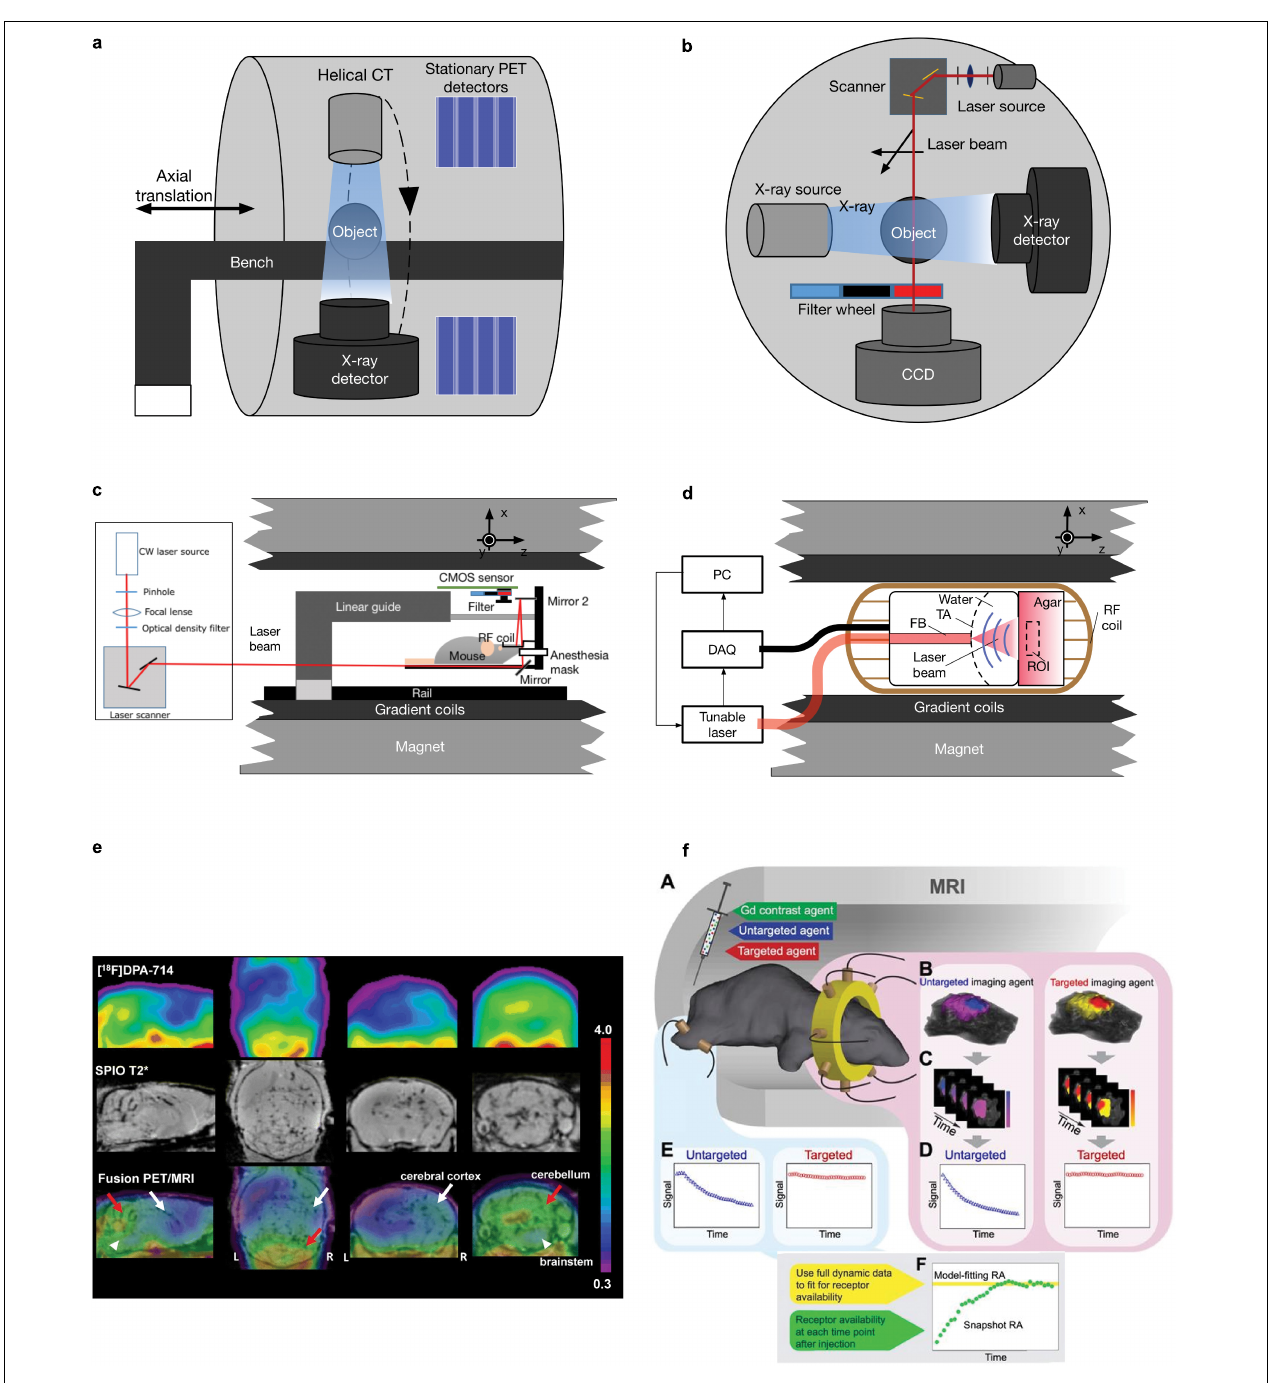
FIGURE 1 | Schematics and example of different small animal hybrid imaging systems. (a) PET-CT uses a coaxial configuration with a helical CT scanner and stationary PET detectors aligned in parallel in one imaging chamber. A movable bench carrying the measured object allows minimal axial translation, facilitating dual-modal imaging. (b) A cross-sectional view of the FMT-CT configuration. In a transmission-mode FMT, the charge-coupled device detector and the illumination module, including a laser source and a scanning device, are placed on the opposite sides of the imaging object. Perpendicular to the optical path of FMT measurement, an X-ray source/detector pair is aligned in the same CT gantry. (c) FMT-MRI can be implemented by using an MR-compatible optical imager inserted into a preclinical MRI scanner. The major component of the insert includes a CMOS array and a customized RF coil [adapted from Ren et al. (63) with permission from Springer Nature]. (d) Similar to FMT-MRI, in OAT-MRI, an MR-compatible ultrasound transducer array together with the coupling medium was used as an OAT insert inside an MRI scanner. A pulsed light source and a data acquisition module (DAQ) are placed outside the MRI bore (adapted from Ren et al. (87) with permission from John Wiley & Sons, Inc. (e) Sagittal, coronal, and transaxial [ 18 F]DPA-714 PET, SPIO T 2 *MRI, and PET/MRI fusion images of a representative